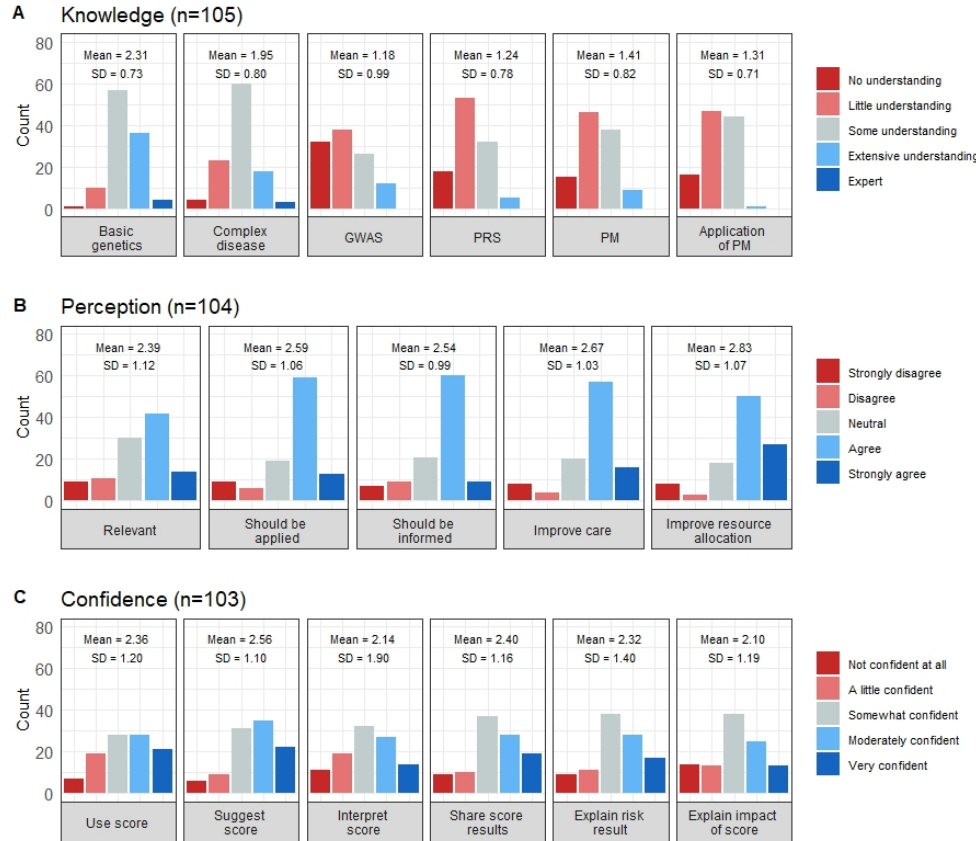
Figure 2. Respondents’ knowledge, perception and confidence of items relating to PM-based CVD risk stratification. The distribution of the clinicians’ responses regarding ( A ) Genetics and PM knowledge, ( B ) Perceptions towards PM-based CVD risk stratification and ( C ) Confidence in applying PM-based CVD risk stratification in clinical practice. GWAS—Genome-wide association studies, PRS—Polygenic risk scores, PM—Precision